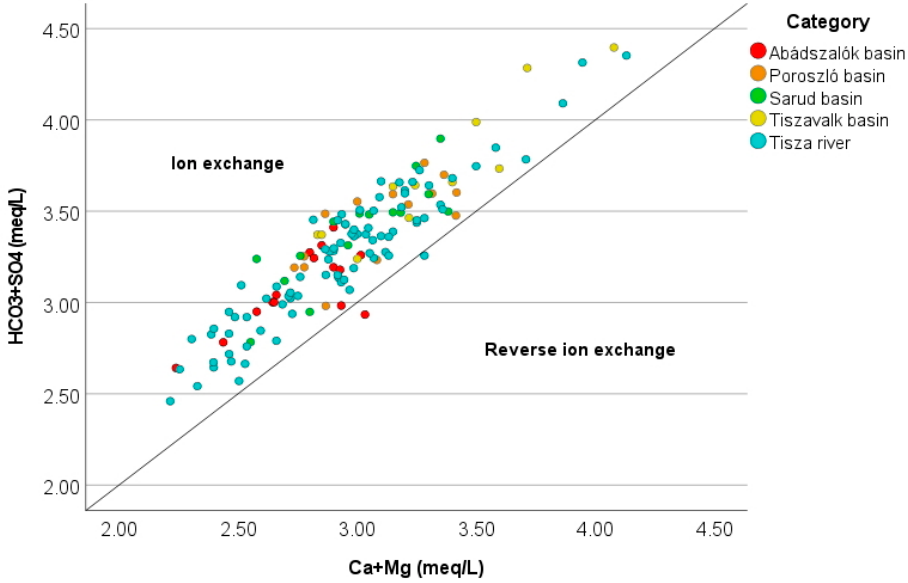
Figure 8. The sca tt er diagram of Ca 2+ + Mg 2+ vs. HCO 3 − + SO 42 − for the di ff erent basins of Lake Tisza Figure 8. The scatter diagram of Ca 2+ + Mg 2+ vs. HCO 3 − + SO 42 − for the different basins of Lake in 2021–2022. Tisza in